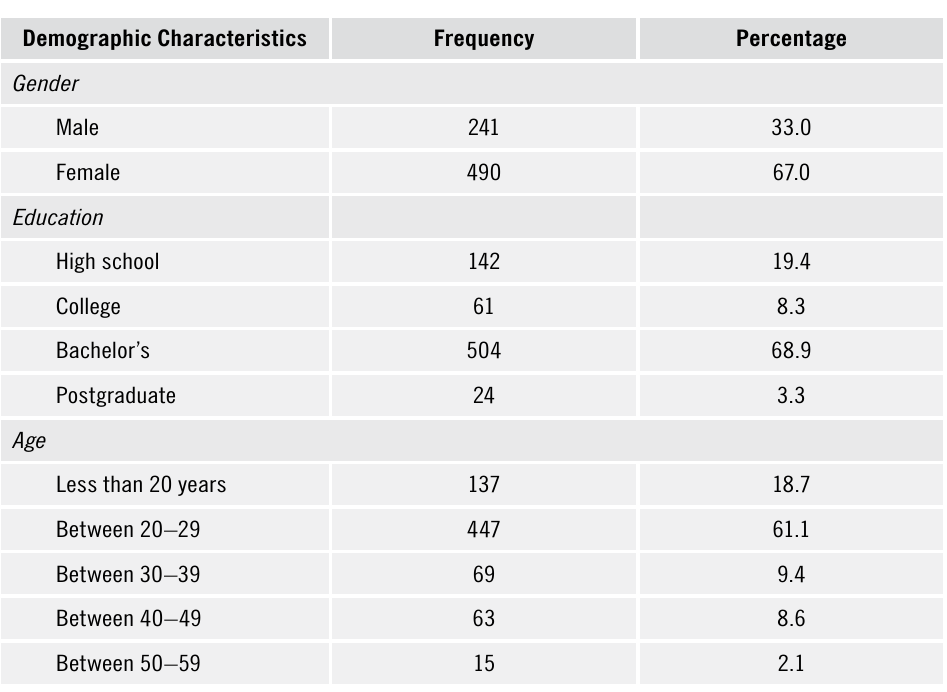
Table 1. Profile of